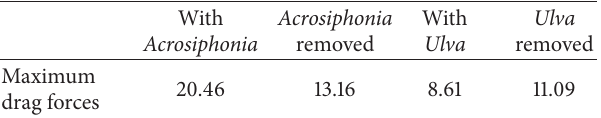
Table 3: Predicted maximum drag forces experienced by limpets with and without epibionts at a water velocity of 20 m/s (theoretical maximum water velocity). Forces are in Newtons.